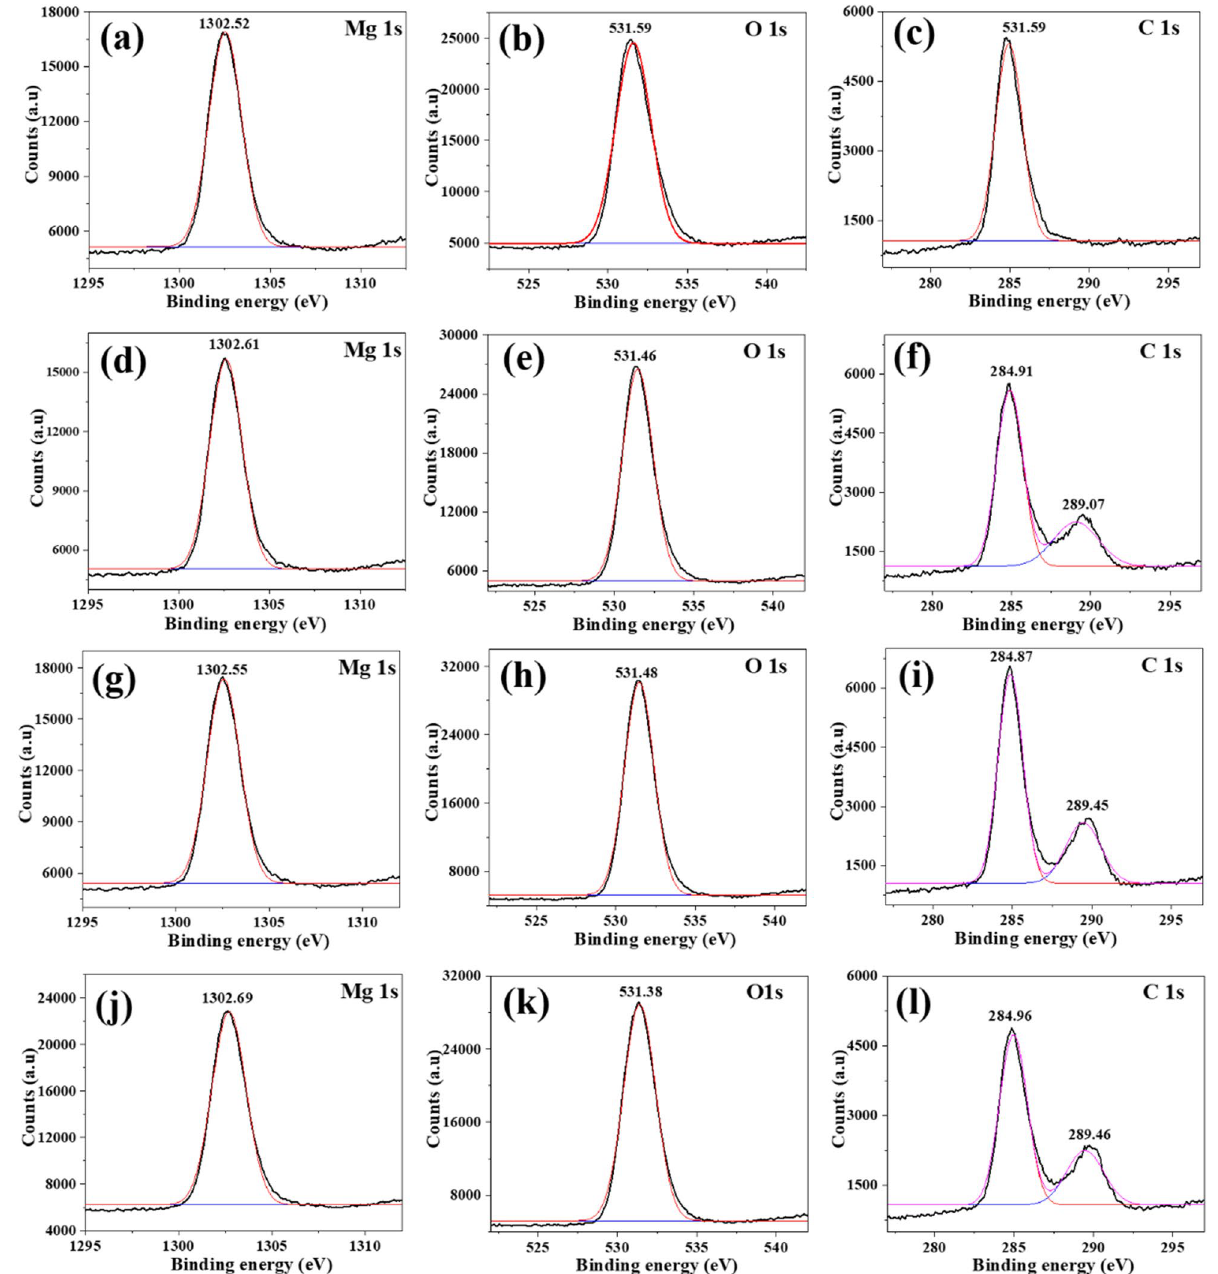
Figure 9. High-resolution spectra of film formed on AZ91 Mg alloy immersed in 3.5 wt% NaCl solution ( a - c ) without and with ( d - f ) GUE, ( g - i ) PDE, ( j - l ) TOE for 24 h at normal atmospheric